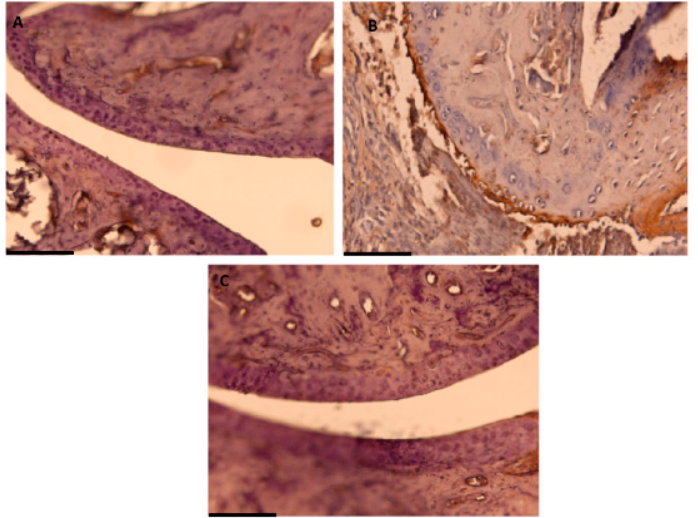
Figure 5. Effect of dietary OLE on COX-2 expression through immunochemistry analysis. Brown color indicates specific immunopositive staining for COX-2. ( A ) COX-2 expression in Naïve group fed with SD with minor or no positive staining. ( B ) Joint section of CIA group fed with SD showing marked expression of COX-2. ( C ) OLE-enriched diet group presenting marked less or no COX-2 immunopositive staining. COX-2 protein production was evaluated in joint sections of different experimental groups. Original magnification ×200 ( A – C ). ( A – C ) Pictures are representative of at least six independent experiments with similar results.